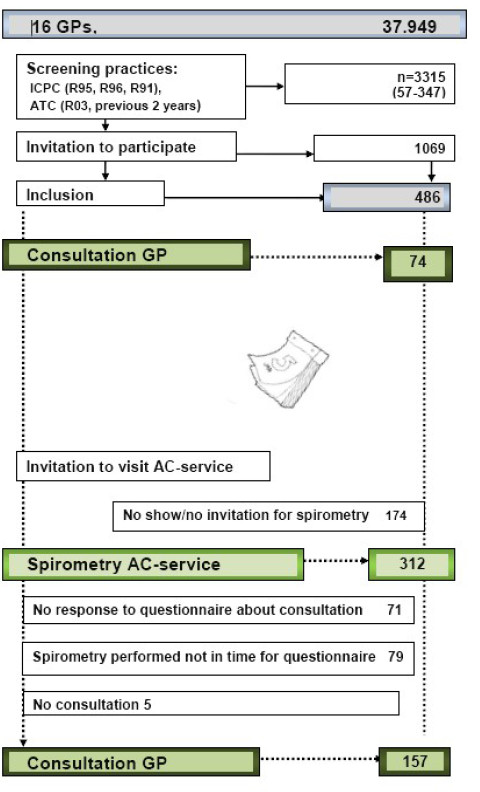
Participating Patients.